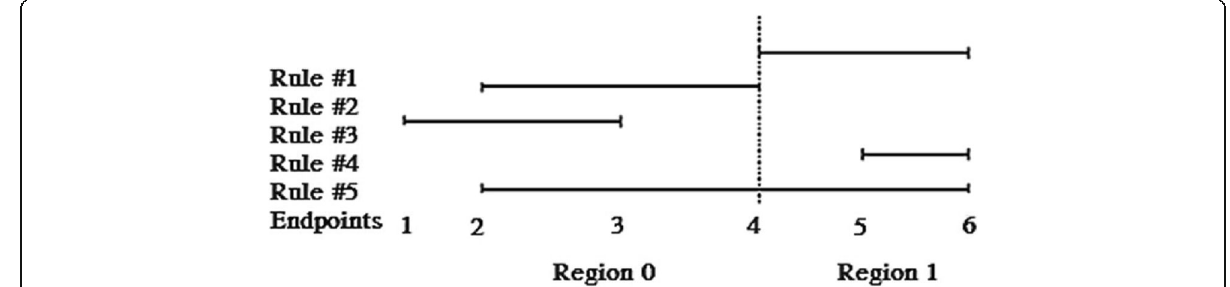
Fig. 2 An example of encoding using the region division encoding algorithm [20,